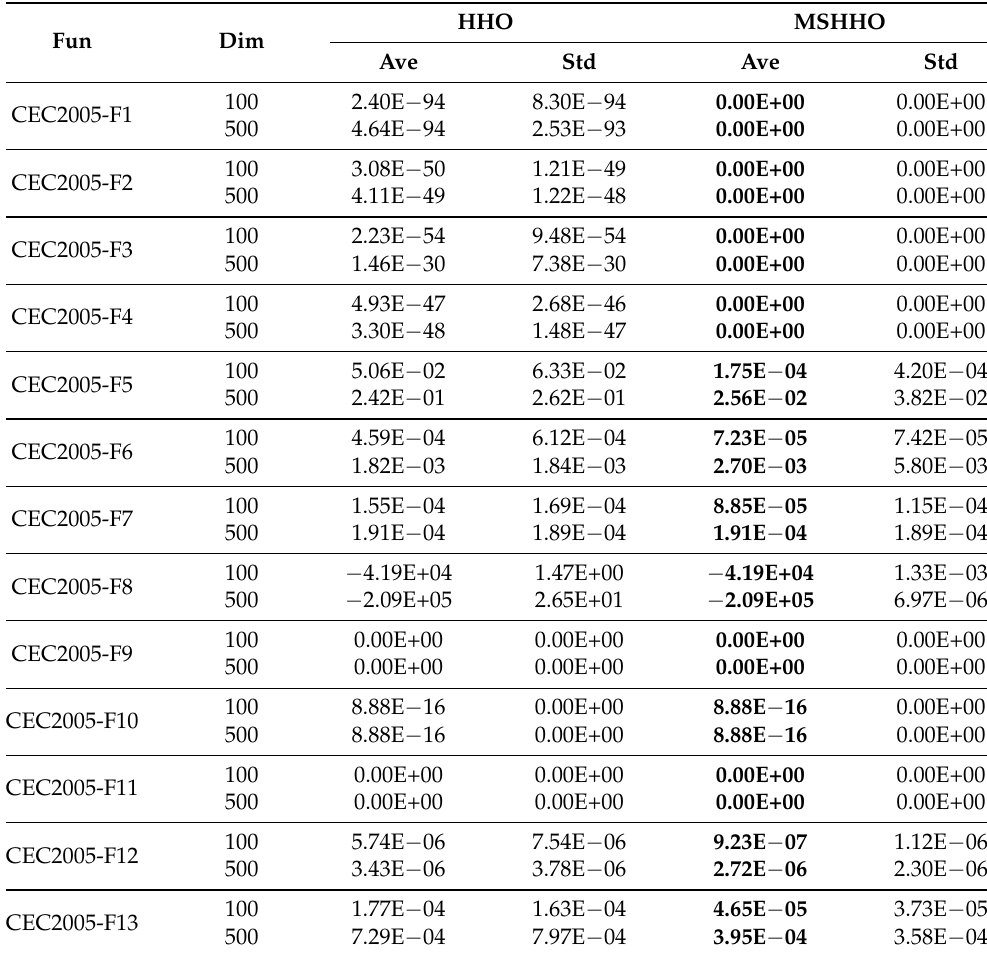
Table 8. Experimental analysis of solving high-dimensional